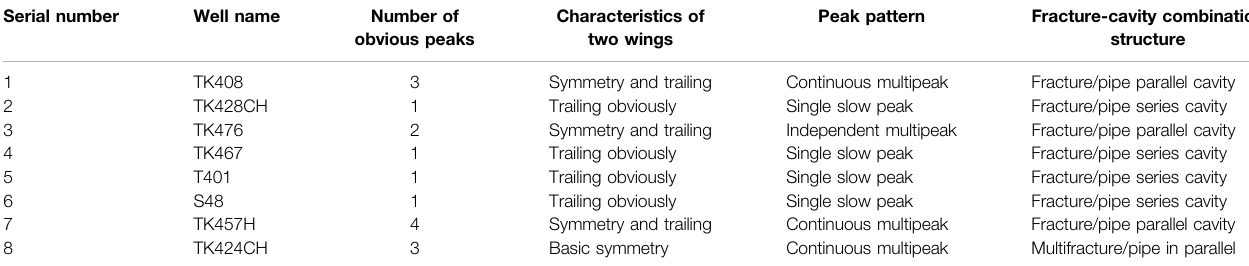
TABLE 2 | Classi fi cation characteristics of interwell tracer curve in fracture-cavity reservoir.